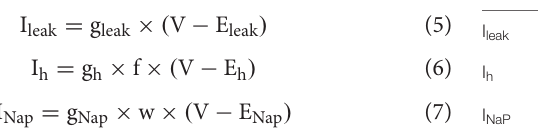
TABLE 1 | Parameters and equations used for calculation of ionic currents in the computational model.